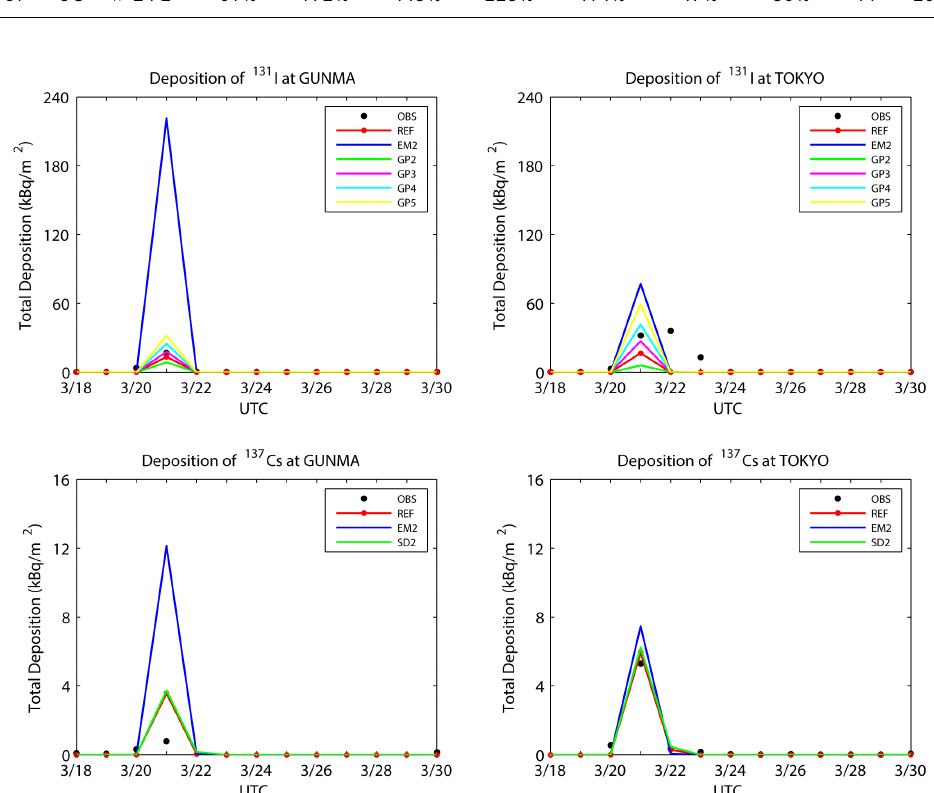
Figure 12. Daily total depositions in station GUNMA and TOKYO with different emission rates, gas partitioning of 131 I and size distribution of 137